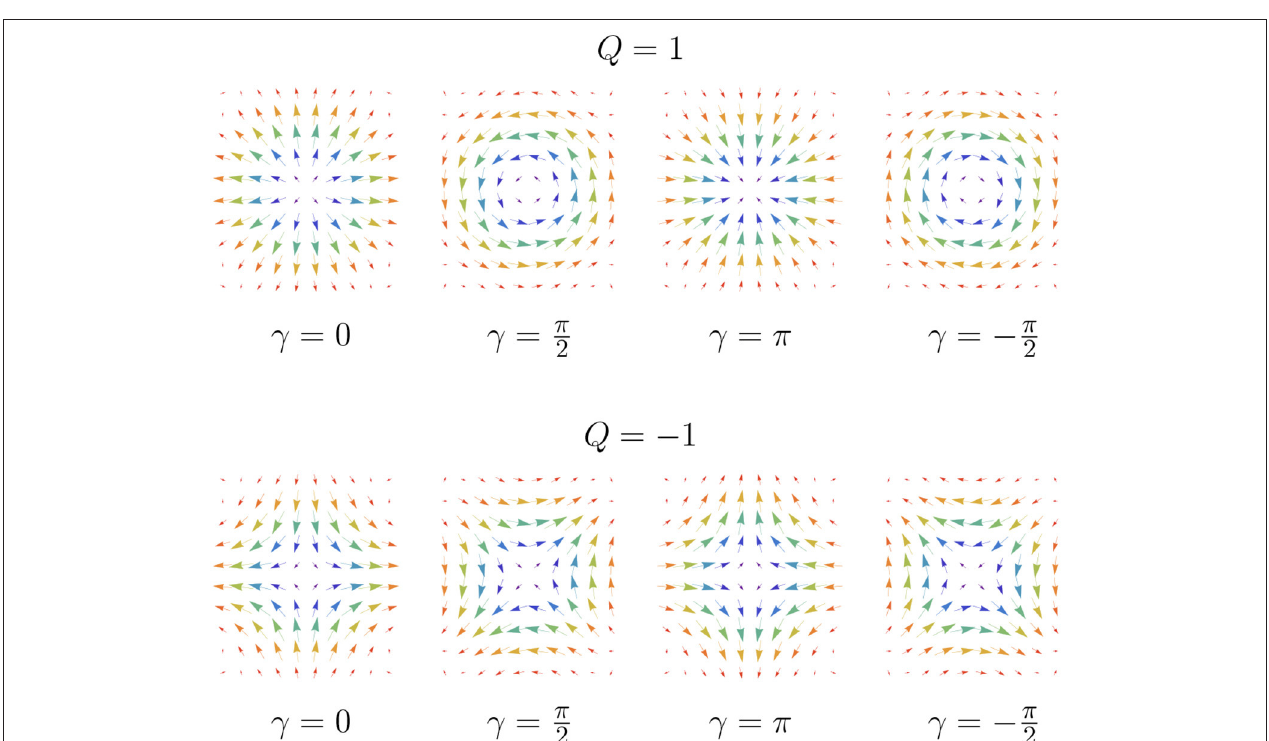
FIGURE 3 | Magnetization configuration of skyrmions ( Q the arrows represent the in-plane component of m , and the color indicates m z . A Néel skyrmion with Q symmetry. A Bloch skyrmion with Q DMI with D 2 d symmetry. An arbitrary helicity γ can be obtained via the global rotation arounds the z -axis by an angle γ . Antiskyrmions can be obtained from skyrmions by a reflection with respect to a plane perpendicular to the plane of the magnet. Figure is adapted with permission from Güngördu et al. [12].